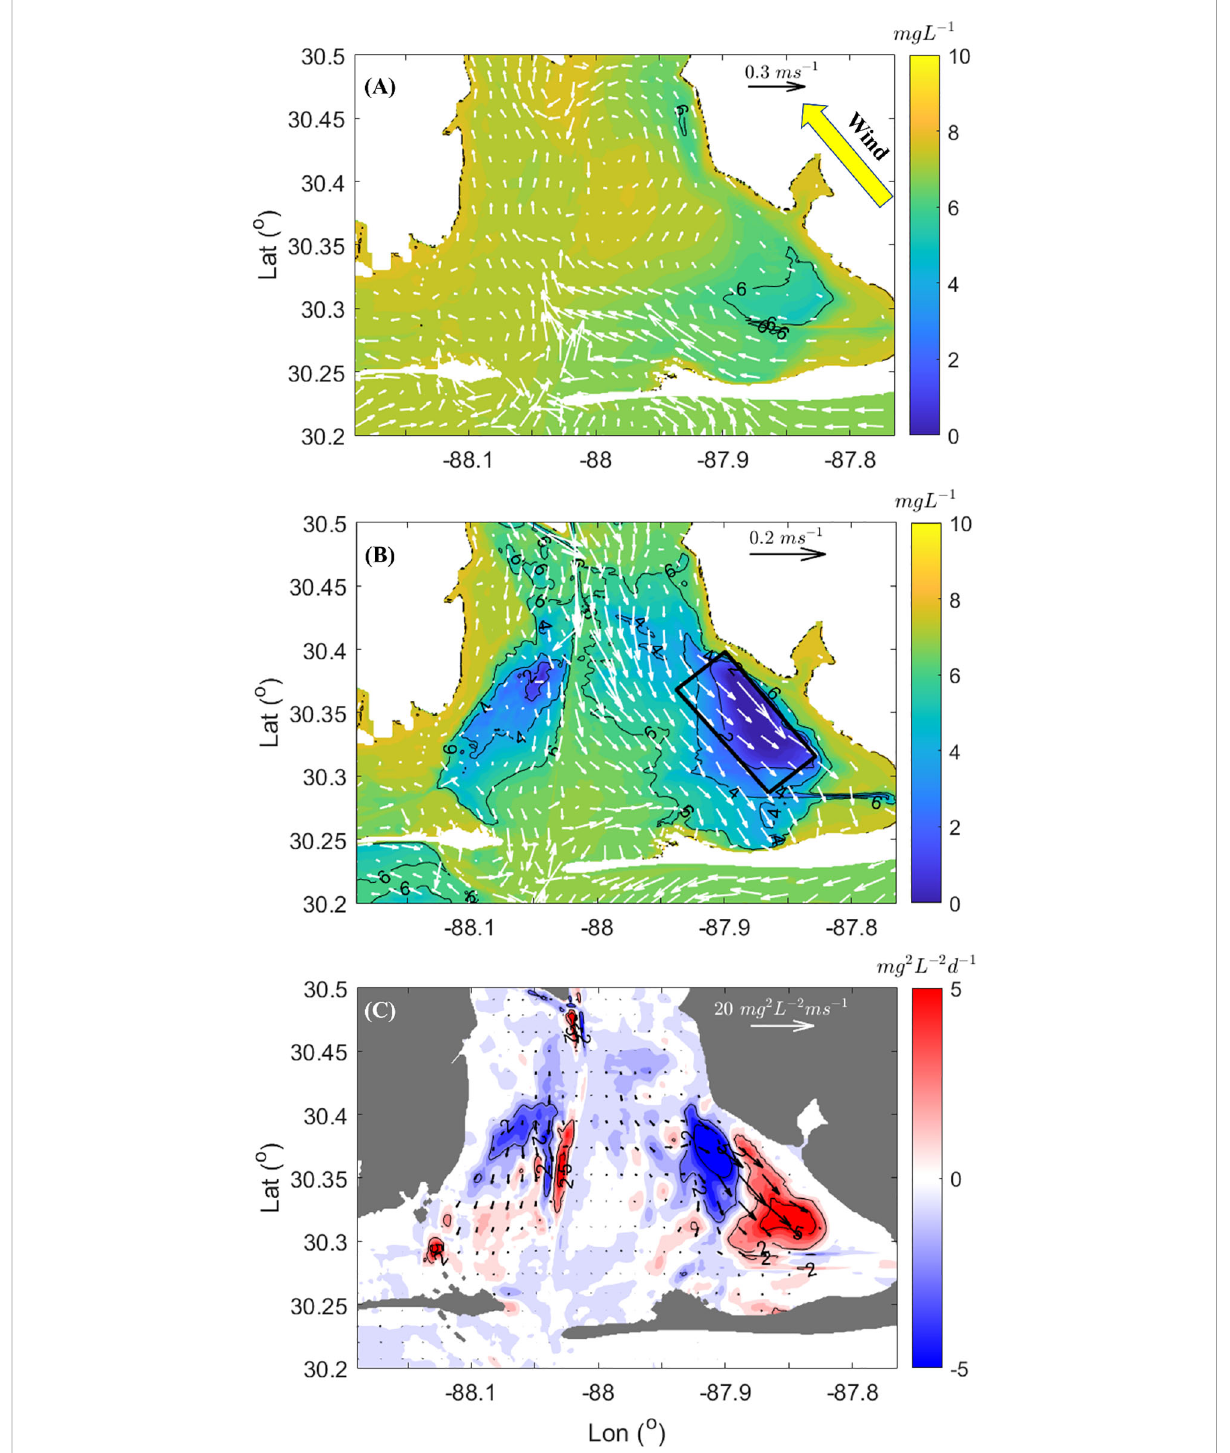
FIGURE 11 Low pass fi ltered current (vectors) and oxygen concentration (contour lines) during peak southeast wind speed (May 9) at surface (A) and bottom (B) . Thick black box denotes spatial averaging zone of Figure 9. (C) Low pass fi ltered depth averaged VDOV fl ux uDO 0 2 and vDO 0 2 (vectors) and advection term in VDOV budget (coloration). Red denotes convergence (incoming) of VDOV fl ux, blue color divergence (outgoing) of VDOV fl